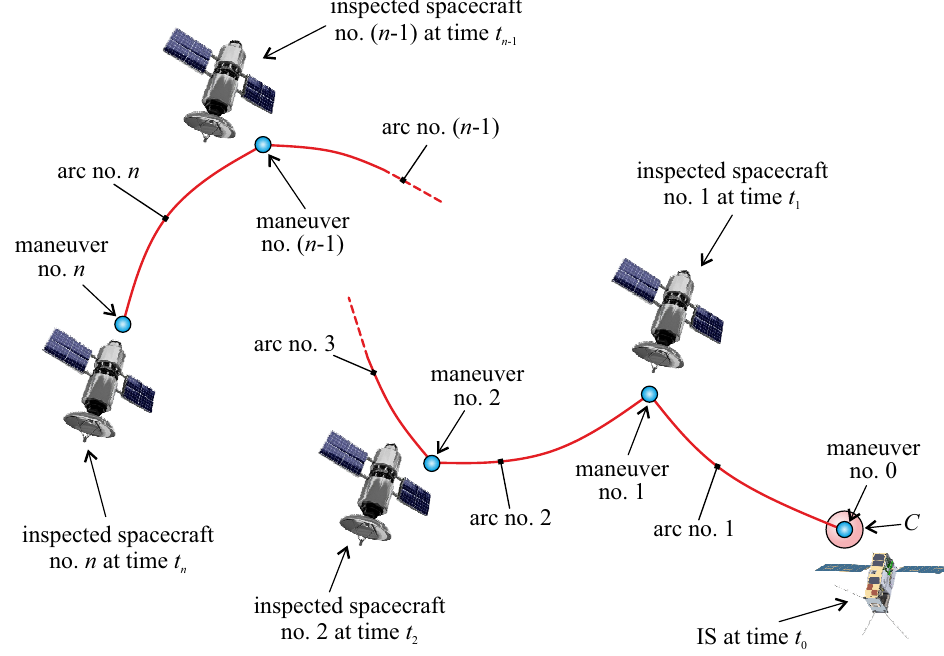
Figure 2. Scheme of the multiple-impulse, rest-to-rest, IS relative